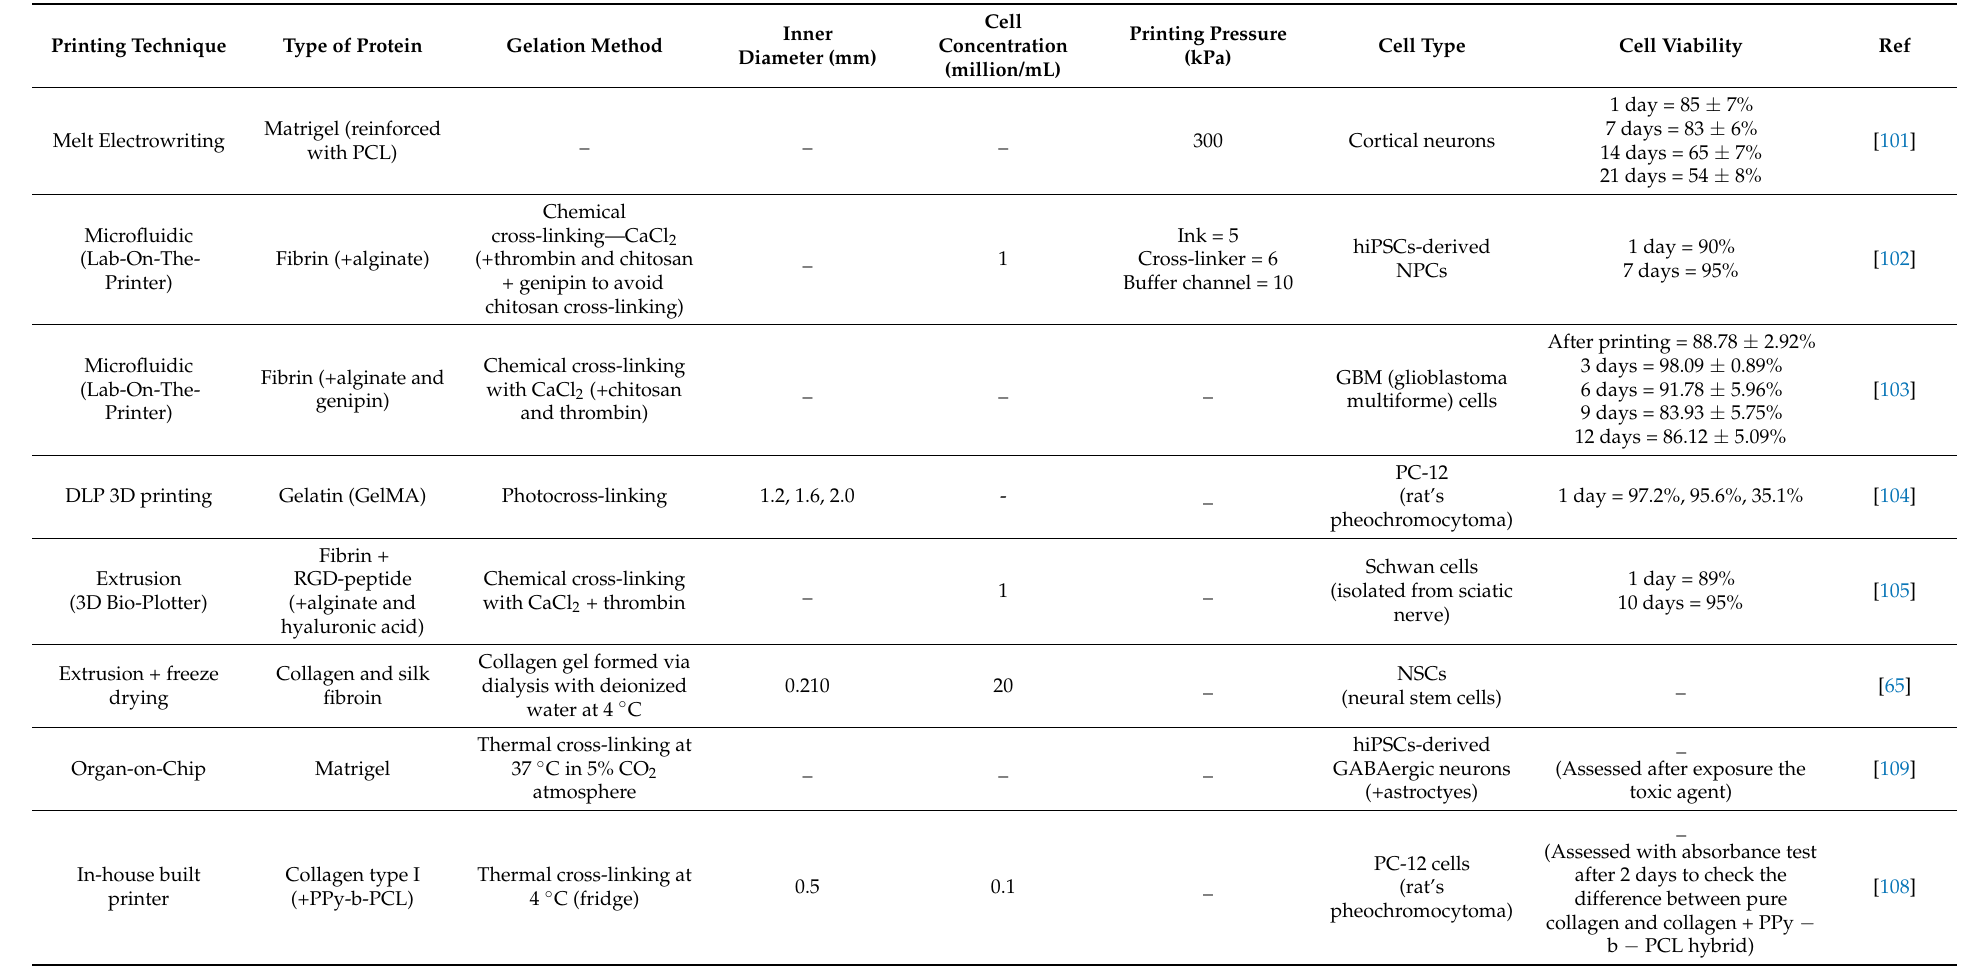
Table 4. Protein-based 3D printed materials in brain tissue